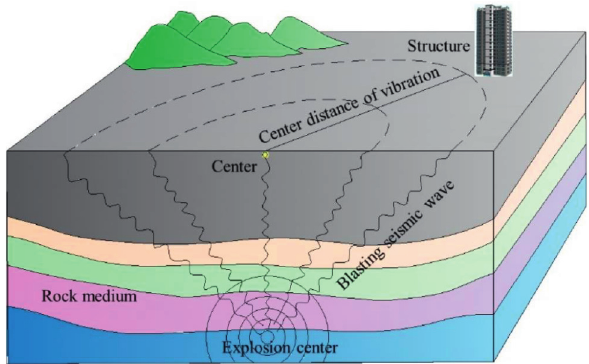
Figure 1: Diagram of blasting vibration